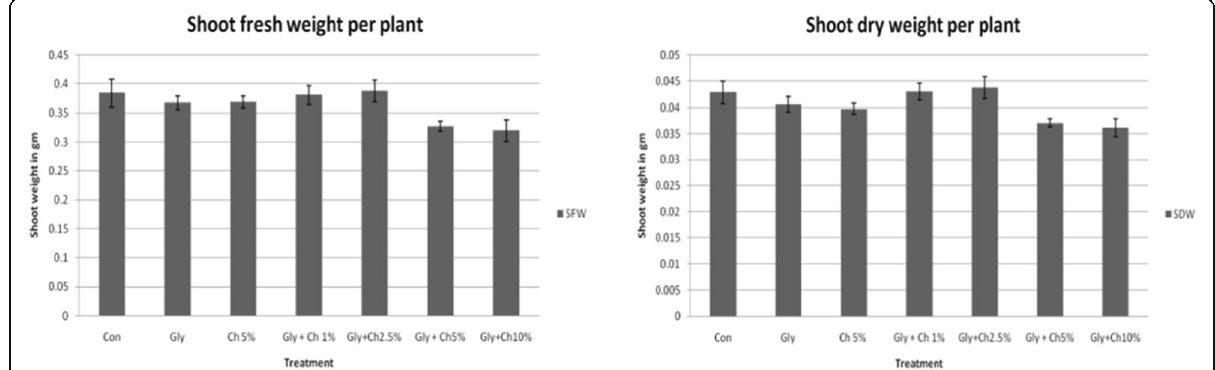
Fig. 3 Shoot fresh and dry weight values of winter wheat seedlings (cv. Isengrain) of different treatments 14 days after seeding. Every data point show average treatment values of four independent replicates. Error bars indicating standard